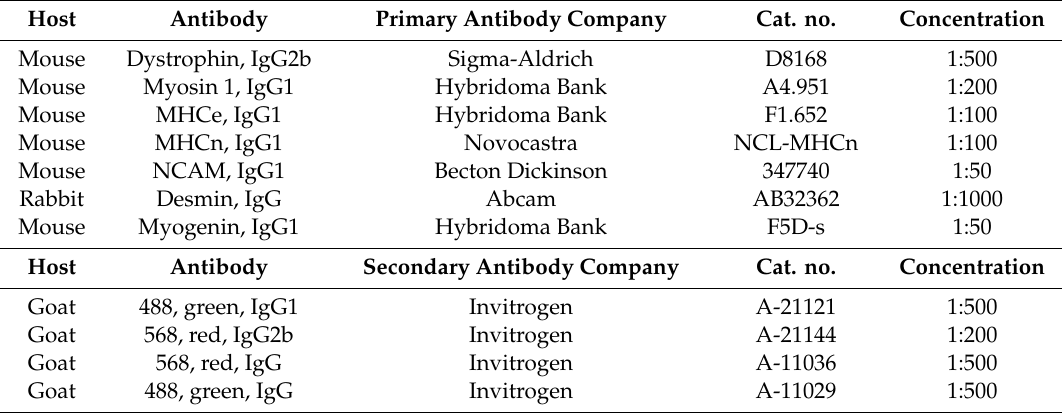
Table 2. Antibodies used for immunohistochemistry and immunocytochemistry. MHCn: